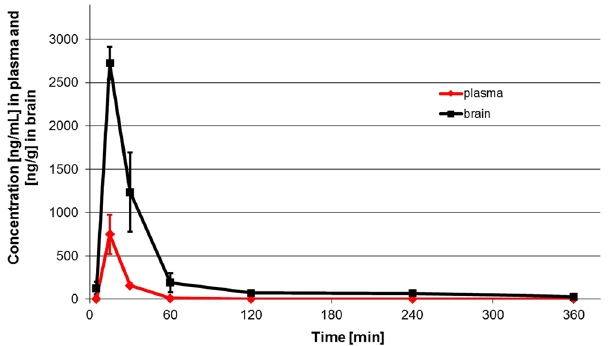
Figure 4. Concentration – time profiles for 1o in plasma and brain after intraperitoneal administration to mice at a dose of 5 mg/kg (linear plots). Concentrations of 1o in plasma and brain are expressed as ng/mL and ng/g, respectively.